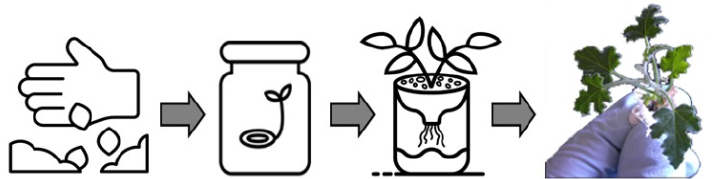
Figure 1. Flowchart of C. colocynthis plantlet cultivation. Manually decoated seeds, previously sorted for viability, were soaked and led to germination in sterilized, wetted cotton wool, then transferred into open-top boxes for liquid cultivation until the stage of 6–7 leaves. Credit for icons: noun-plant-seeds-5083968 by Black, noun-plants-1731784 by BGBOXXX Design and noun-hydroponic-1890773 by Wahyu Hadi from “The Noun Project” (https://thenounproject.com (accessed on 17 July 2022)). Extracts were obtained from 7 g lyophilized plantlets and 2 g seed coats (tegument): the extraction yield obtained was settled at 1.057 g for ethanol-extracted plantlets (PL-EtOH)